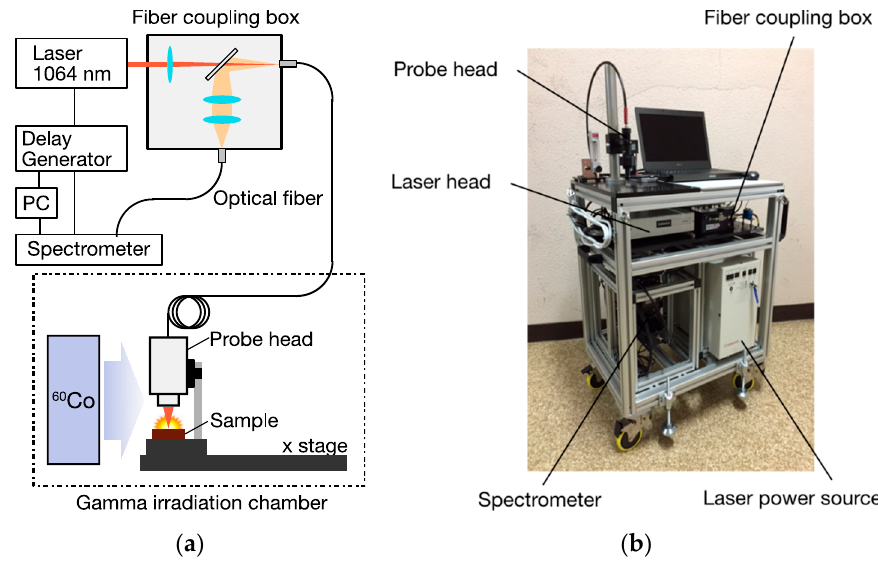
Figure 1. Overview of the experimental setup. ( a ) Schematic of the fiber-optic laser-induced breakdown spectroscopy (FO-LIBS) system. ( b ) Photograph of the FO-LIBS apparatus.